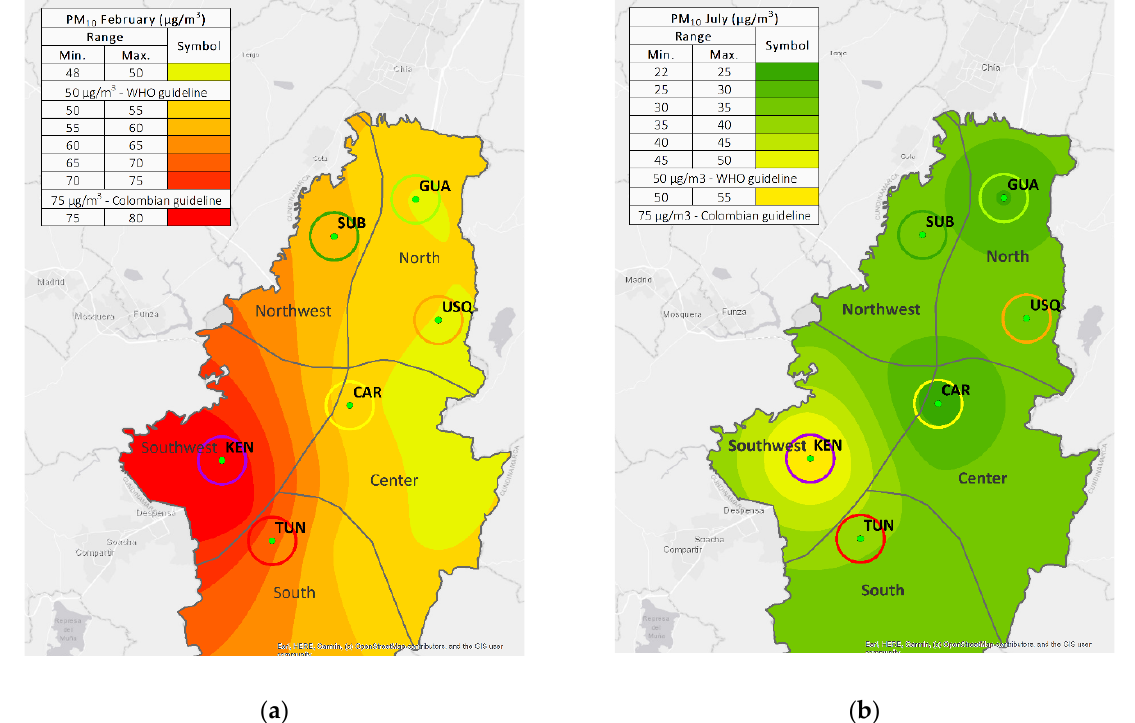
Figure 4. Average spatial variation of PM 10 concentration in Bogotá D.C. during ( a ) the most critical month (February) and ( b ) the least critical month (July).